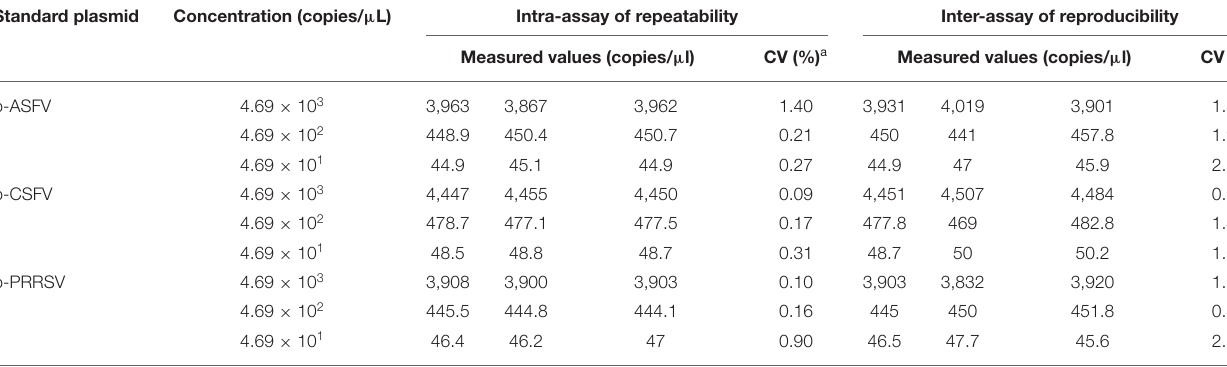
a CV stands for coefficient of variation.